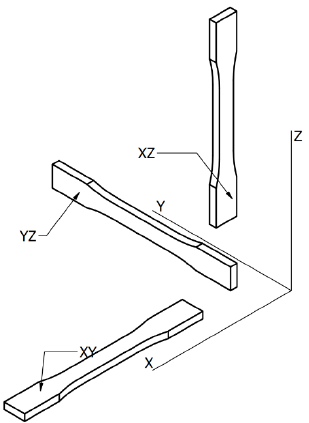
Figure 2. Specimen build plate orientation. Polymers 2022 , 14 , x